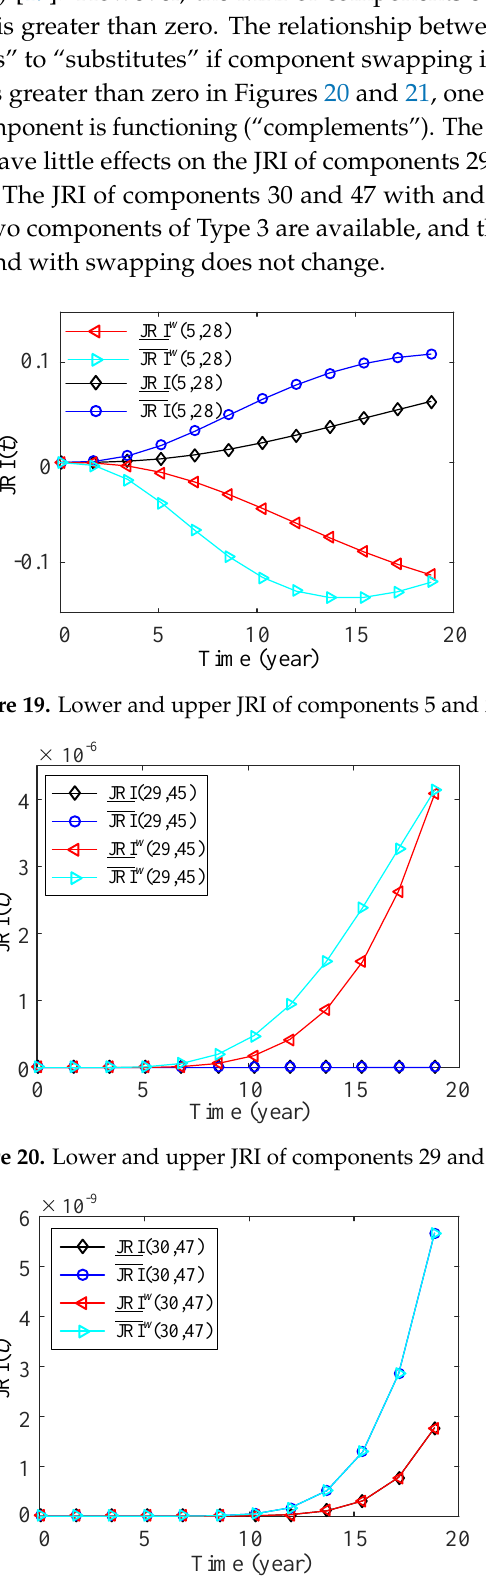
Figure 21. Lower and upper JRI of components 30 and